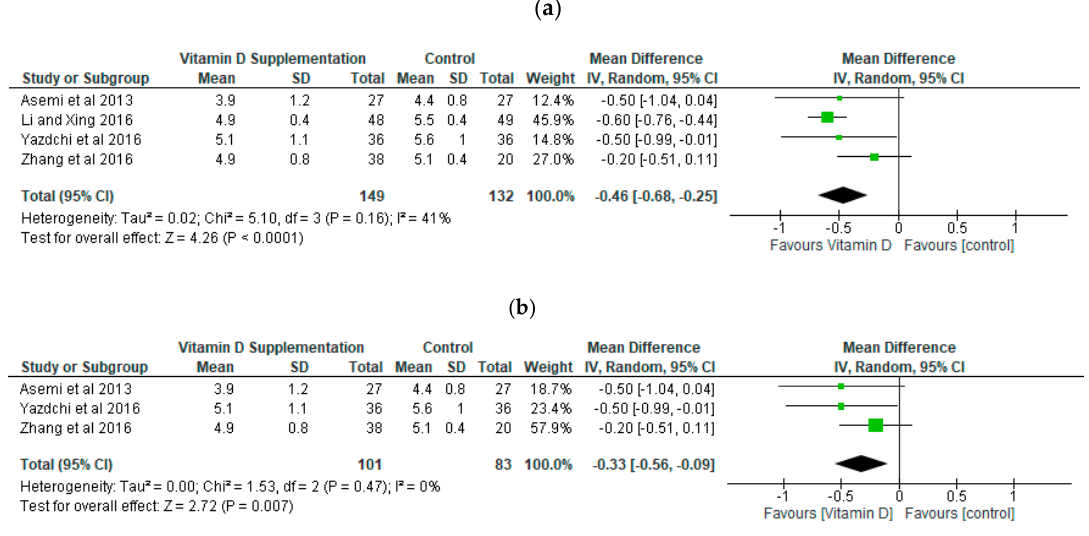
Figure 4. Forest Plot of Fasting Blood Glucose (mmol / L). ( a ) Meta-analysis; ( b ) Sensitivity analysis.